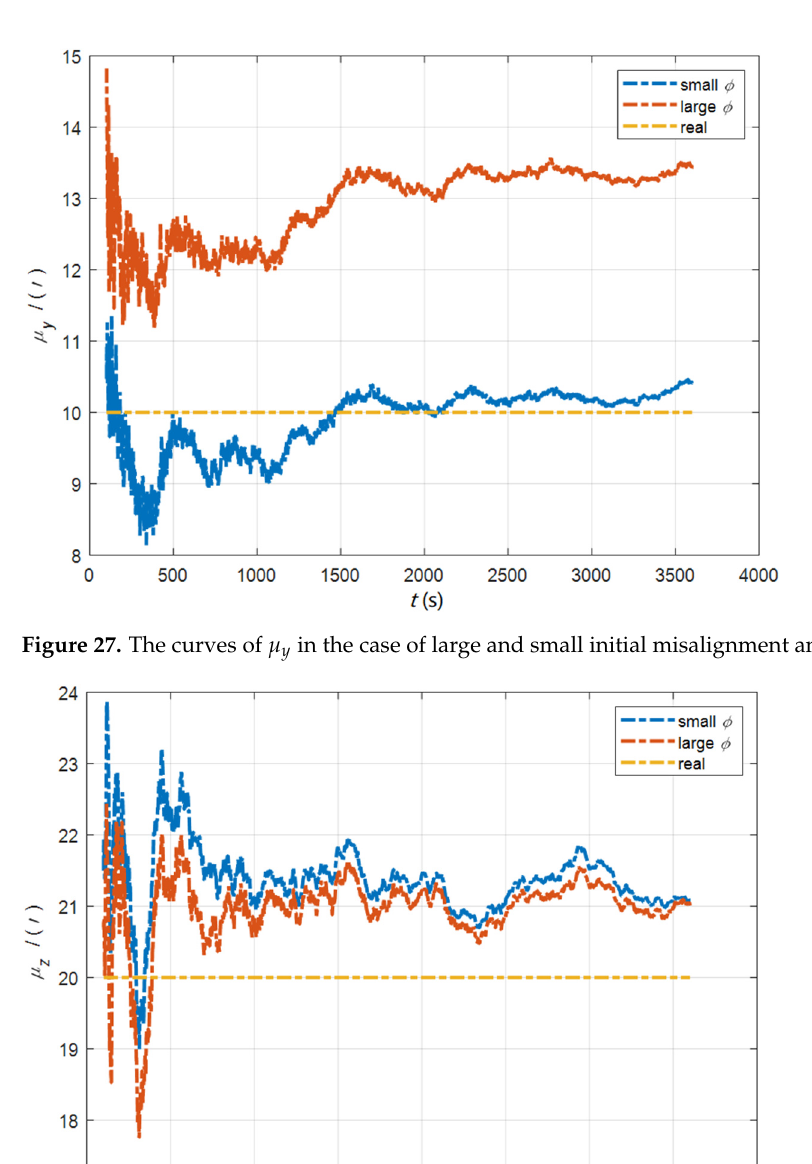
Figure 28. The curves of